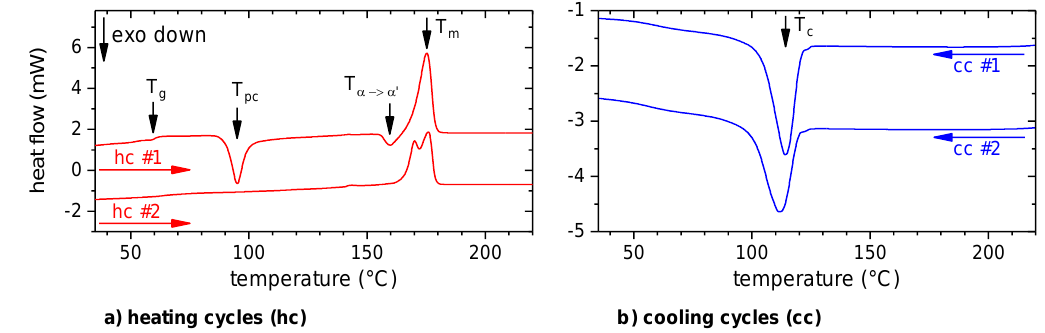
Figure 4. Parallel shifted heat flows of the first and second heating (hc) and cooling (cc) cycles with marked temperatures for T g : glass transition, T pc : post crystallization, T α → α ’ : crystalline phase transition, T m : melting and T c : crystallization. The heating and cooling rate was 10 K/min for each ◦ ◦ cycle. The temperature ranges for the glass transition, T g = 60.5 C, post-crystallization, T pc = 95.1 C, ◦ ◦ melting, T m = 175.2 C and crystallization, T c = 114.1 C (cf. Figure 4), as obtained in the first DSC cycle, are compliant with data from datasheet [32] and literature (cf., e.g.,